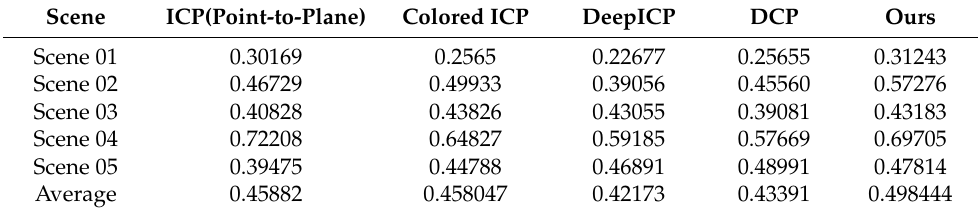
Table 1. Recall ( τ = 0.5).